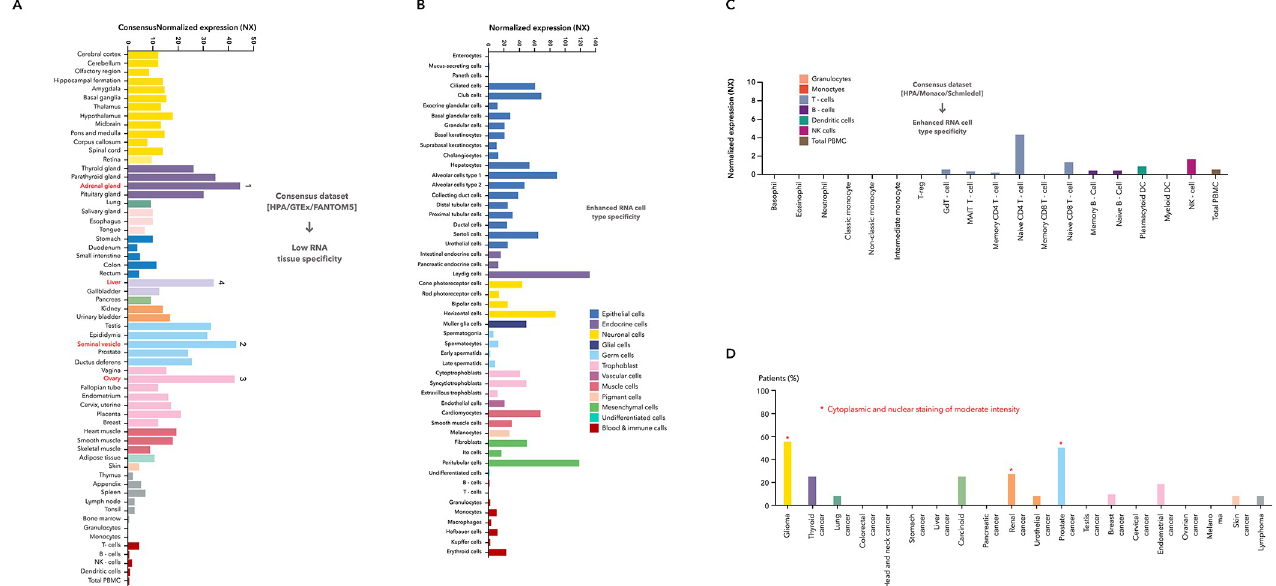
Fig 1. SMARCA1 expression in different cells, tissues in the physiological and pathological status. (A) Analysis of SMARCA1 gene expression in different tissues by the consensus datasets of HPA, GTEx and FANTOM5; (B) Analysis of SMARCA1 gene expression in different single cell types; (C) Analysis of SMARCA1 gene expression in different blood cells by the consensus datasets of HPA, Monaco and Schmiedel. (D) Analysis of SMARCA1 gene expression in different cancer tissues.